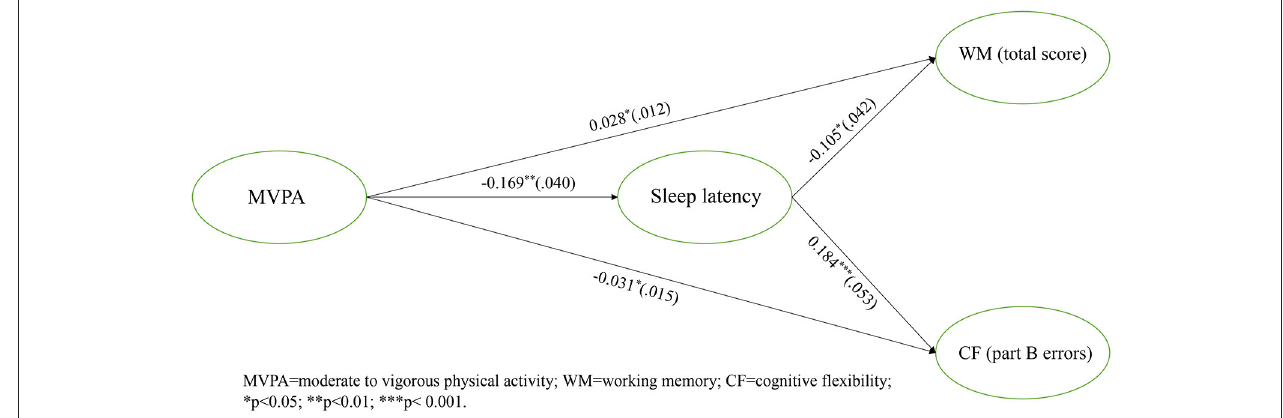
FIGURE 2 | Final model with significant standardized estimates and standard errors. MVPA, moderate to vigorous physical activity; WM, working memory; CF, cognitive flexibility; * p < 0.05; ** p < 0.01; *** p <